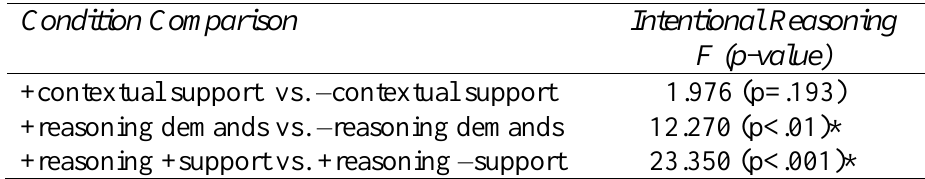
Repeated Measures Analysis for Spatial Reasoning